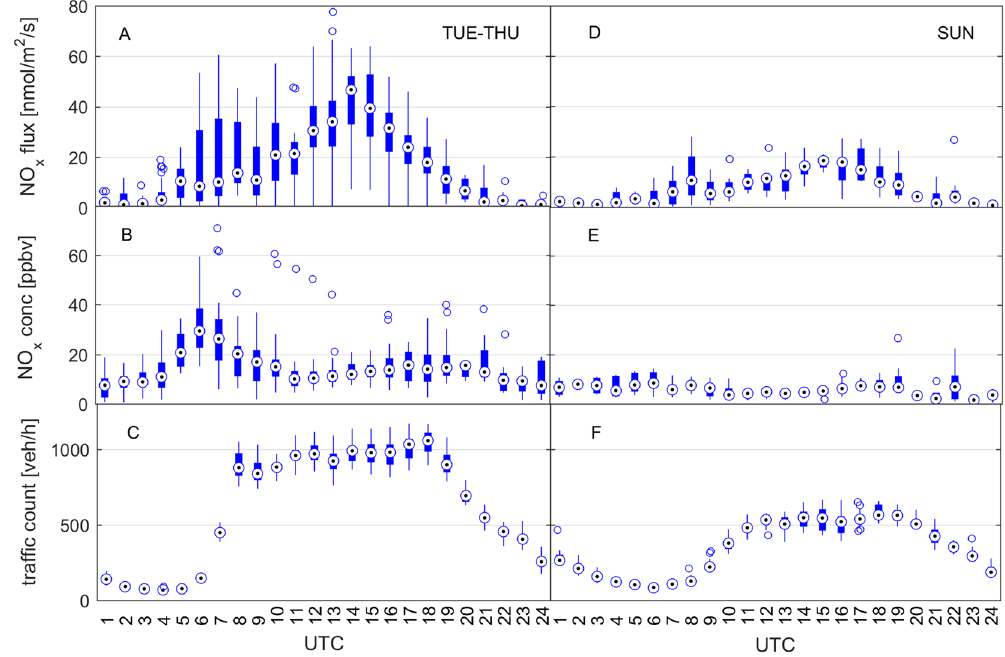
Figure 1. Statistical plot of measured NO x fluxes, mixing ratios and traffic count data. The center dot shows the ensemble median, where the box around it represents one standard deviation and whiskers the 25 and 75% percentile. Individual extreme values are plotted as open circles. Panels A, B and C represent weekdays (i.e. TUE-THU; composite of 609 individual data points) and panels D, E and F depict Sundays (193 individual data points).